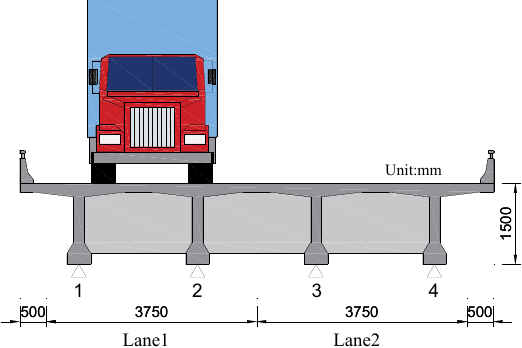
Figure 6. Loading position of vehicles and bridge cross-section.